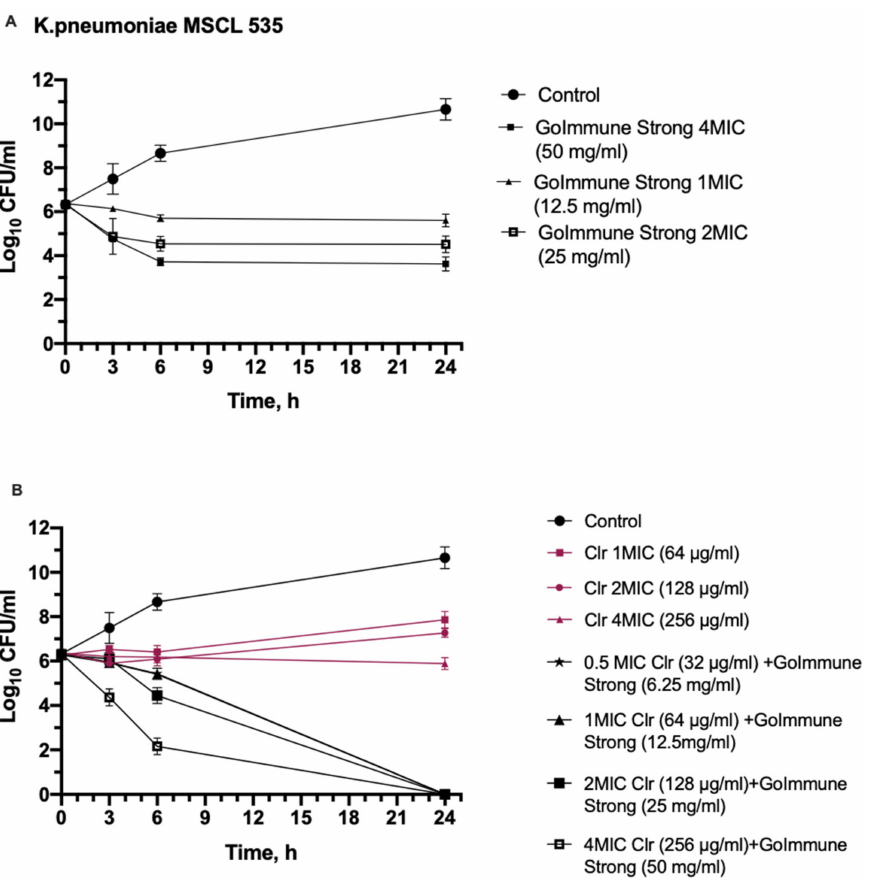
Figure 1. Time-kill curves show synergistic interaction between GoImmune Strong ® complex and clarithromycin (Clr) against K. pneumoniae . ( A )—time-kill curves of GoImmune Strong ® complex at different concentrations. ( B )—Time-kill curves of combination of GoImmune Strong ® complex and clarithromycin. Each time-curve experiment was performed in duplicate and diluted samples were plated in duplicate on agar plates. Error bars indicate standard